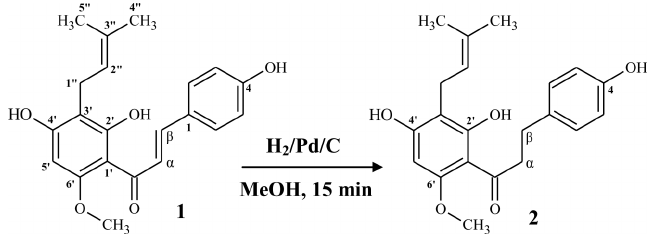
Figure 1. Synthesis of α , β -dihydroxanthohumol ( 2 ) from xanthohumol ( 1 ) [34].